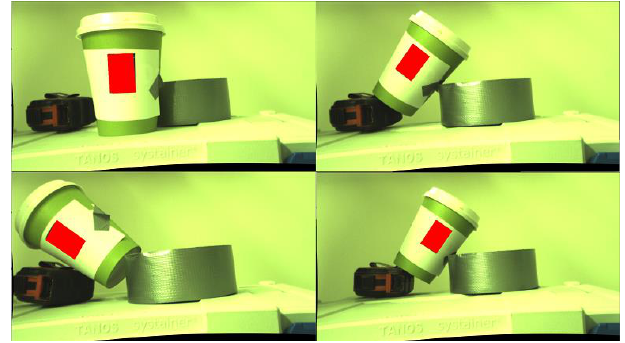
Fig. 4. Object recognition with black circle mark from different positions and orientation in a bright light condition.